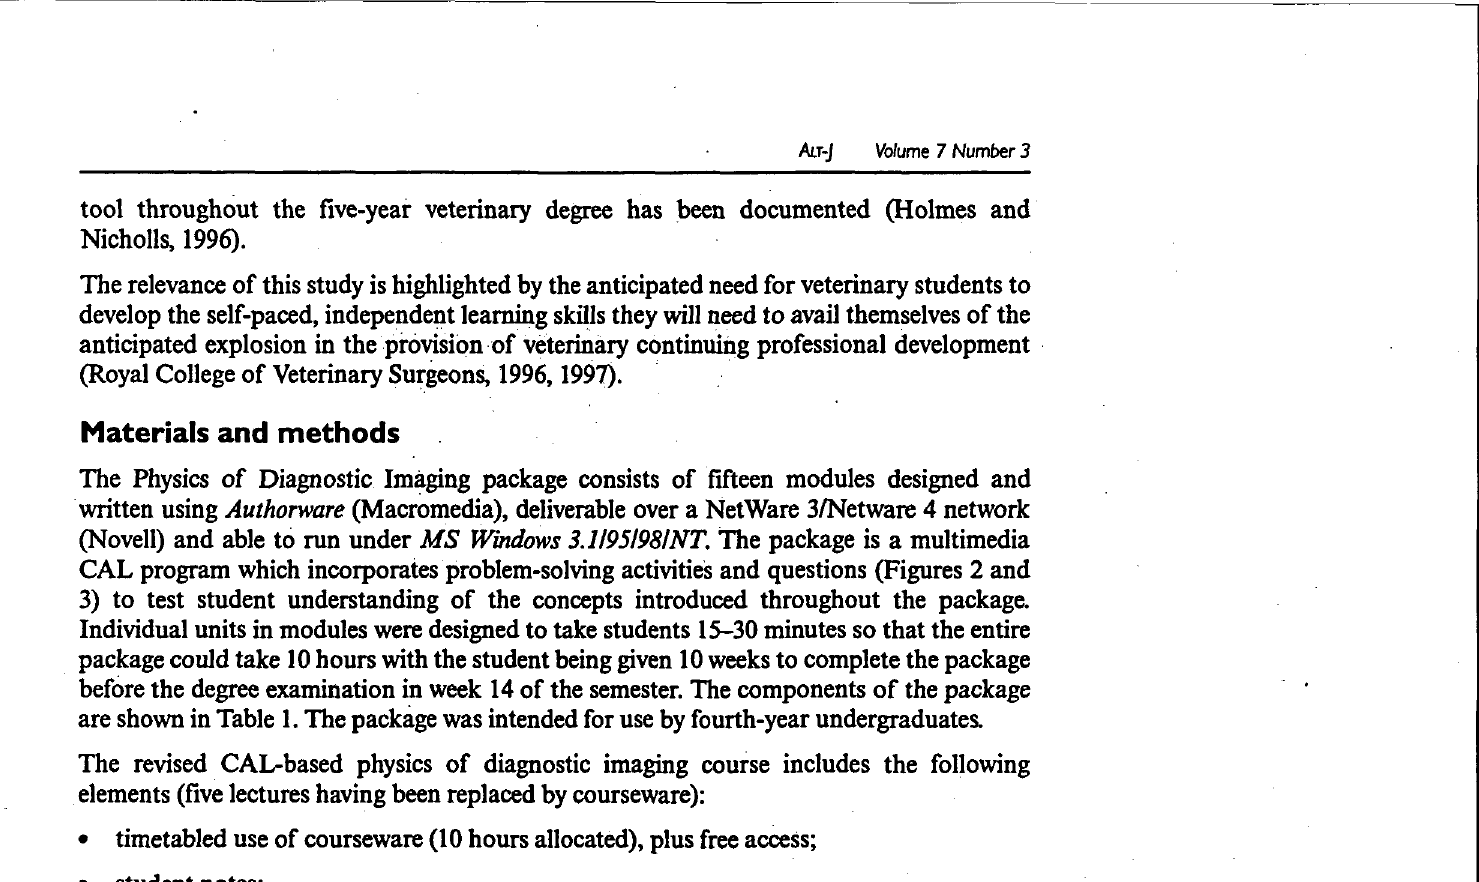
Generation of high speed electrons